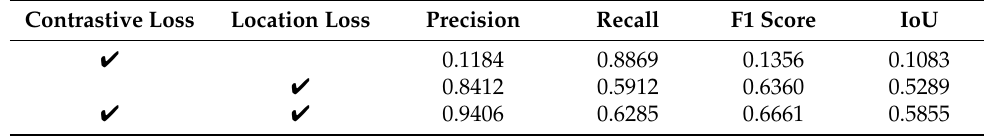
Table 2. Ablation results of using different loss